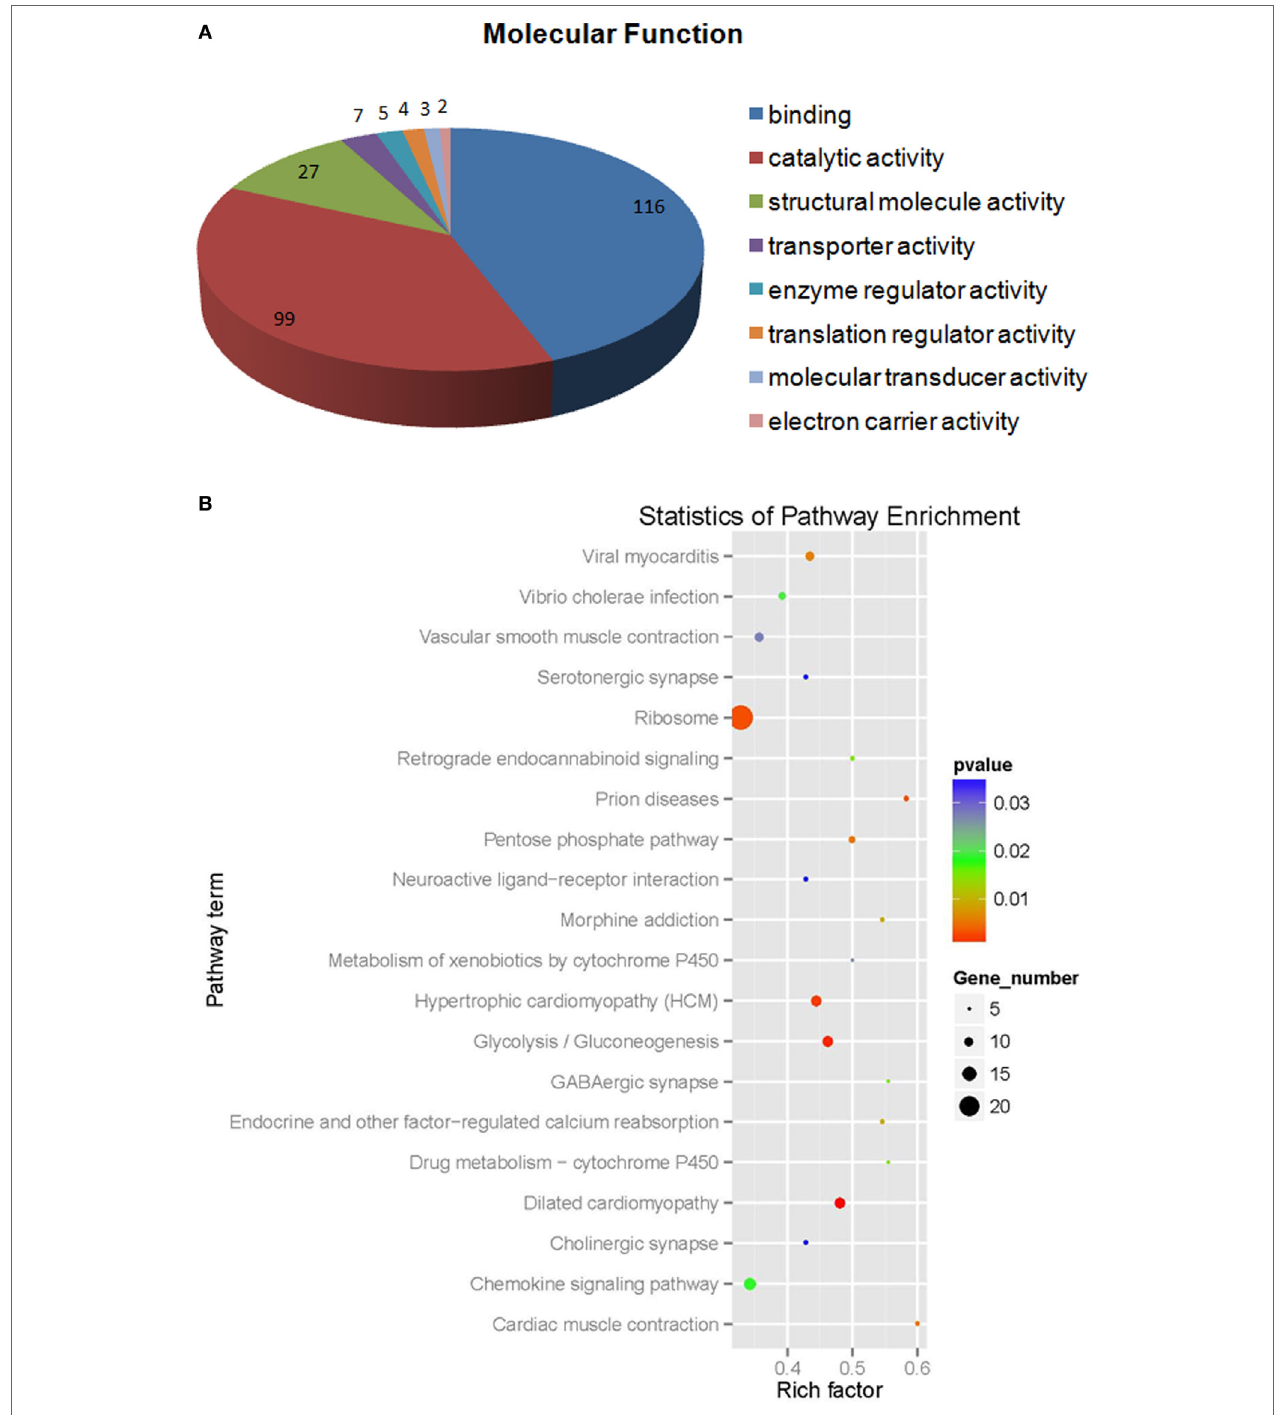
FigUre 4 | The molecular function (a) statistics of pathway enrichment (B) of differential expressed proteins (more than 1.2-fold) from white spot syndrome virus group vs control group